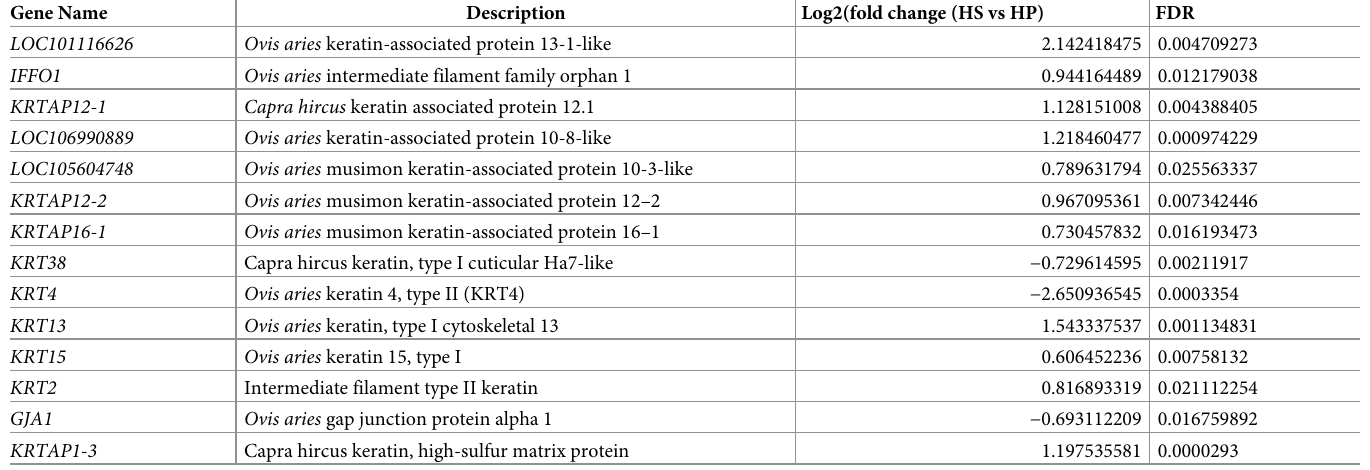
Table 4. Expression of KAP and KIF